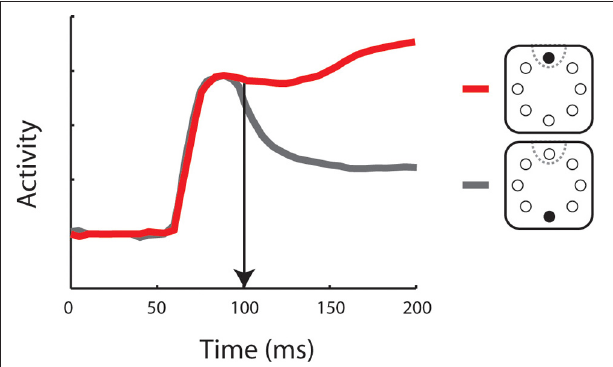
FIGURE 2 | Neuronal activity representing a salient stimulus. Schematic illustration of a post-stimulus time histogram representing neuronal responses to two stimulus conditions. Insets depict the salient stimulus appearance in (red) or out (gray) of the neuron’s receptive field (dotted line). Vertical arrow indicates the time of neuronal target discrimination. The diagram was constructed based on the results of Thompson and colleagues [Thompson et al.